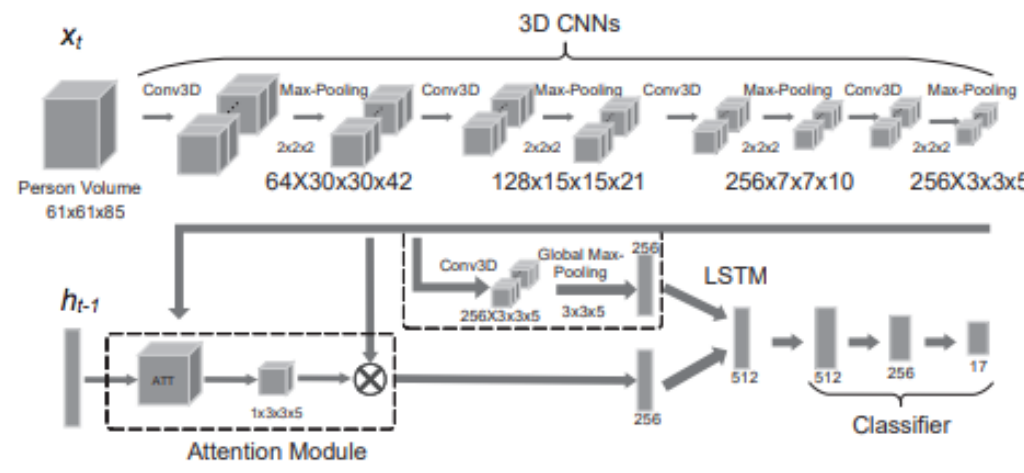
Figure 9. Action 4D attention neural network structure from